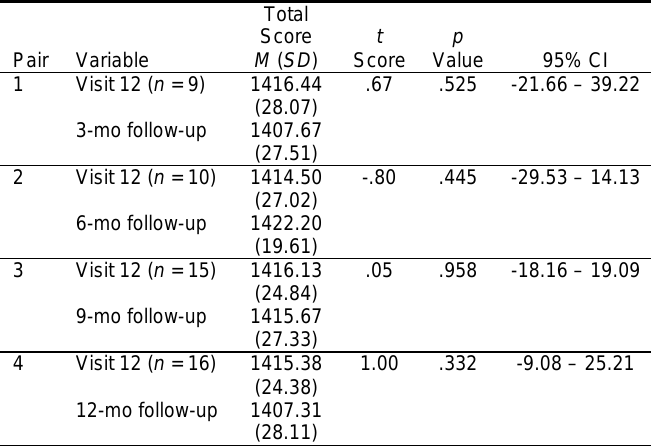
Table 2. Comparison of visit 12 and follow-up visits